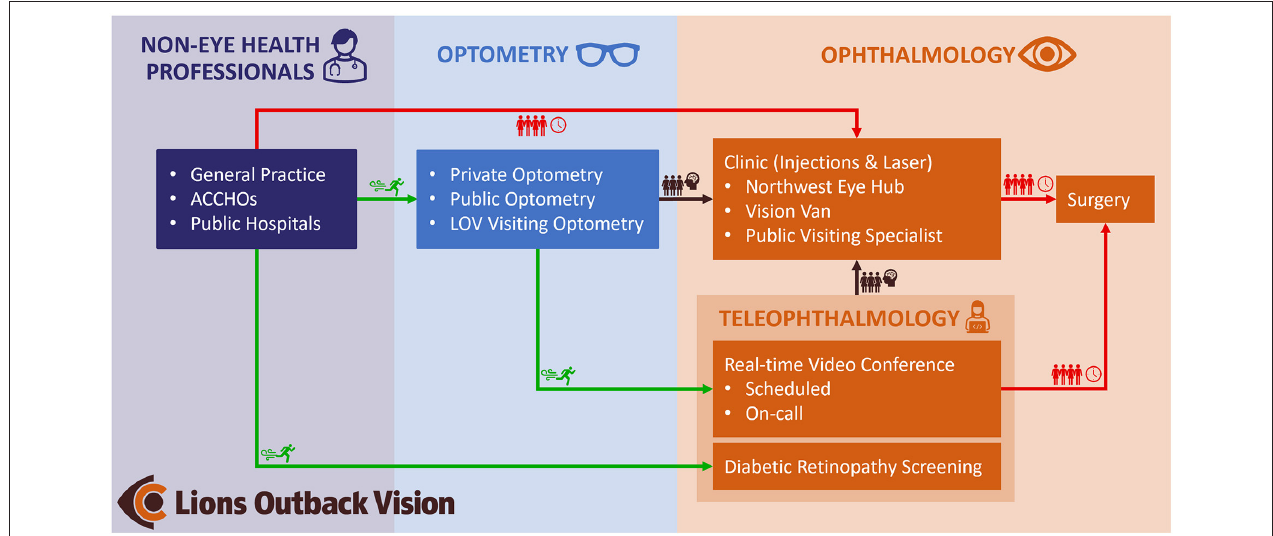
FIGURE 1 | Clinical pathway demonstrating the role of teleophthalmology within Lions Outback Vision. Teleophthalmology enables fast-track access (green) for patients to specialist care compared to traditional referral pathways which are congested (red). By diverting referrals from non-eye care professionals via optometry and diabetic retinal screening, specialist clinics can manage well-triaged pathology (brown). ACCHOs, Aboriginal Community Controlled Health Organizations; LOV, Lions Outback